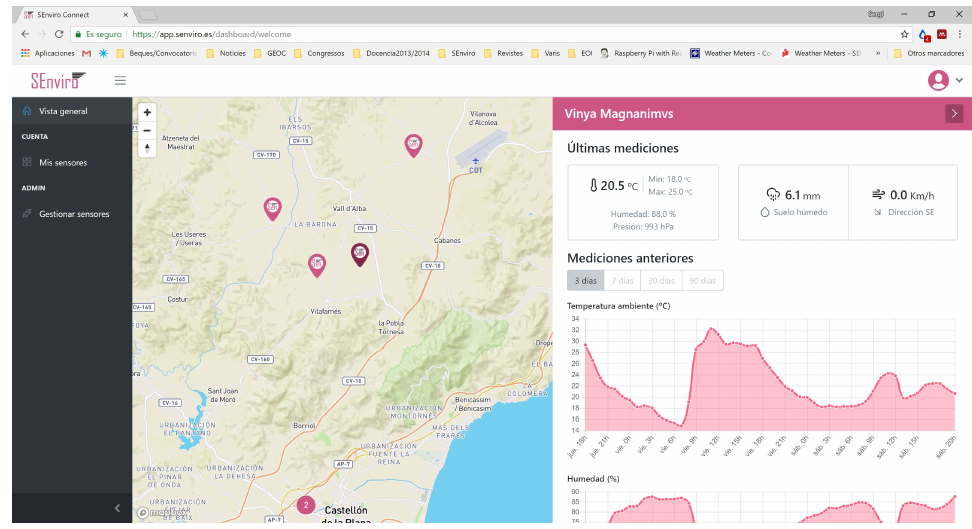
Figure 16. A screenshot of the SEnviro connect showing the data and alerts for each